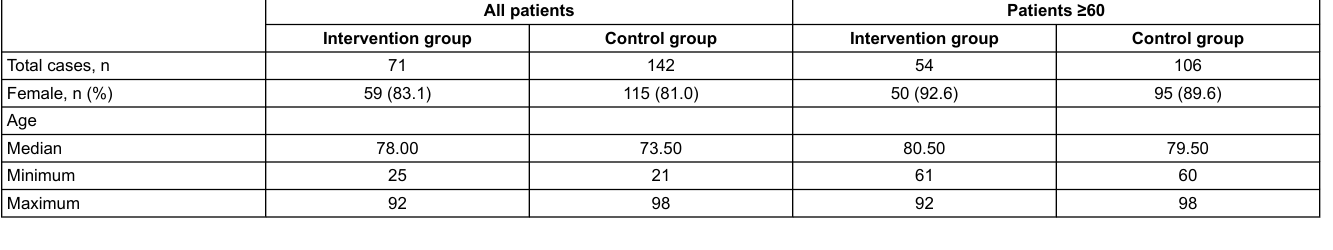
Table 2: Operation rates for all patients and patients aged ≥60